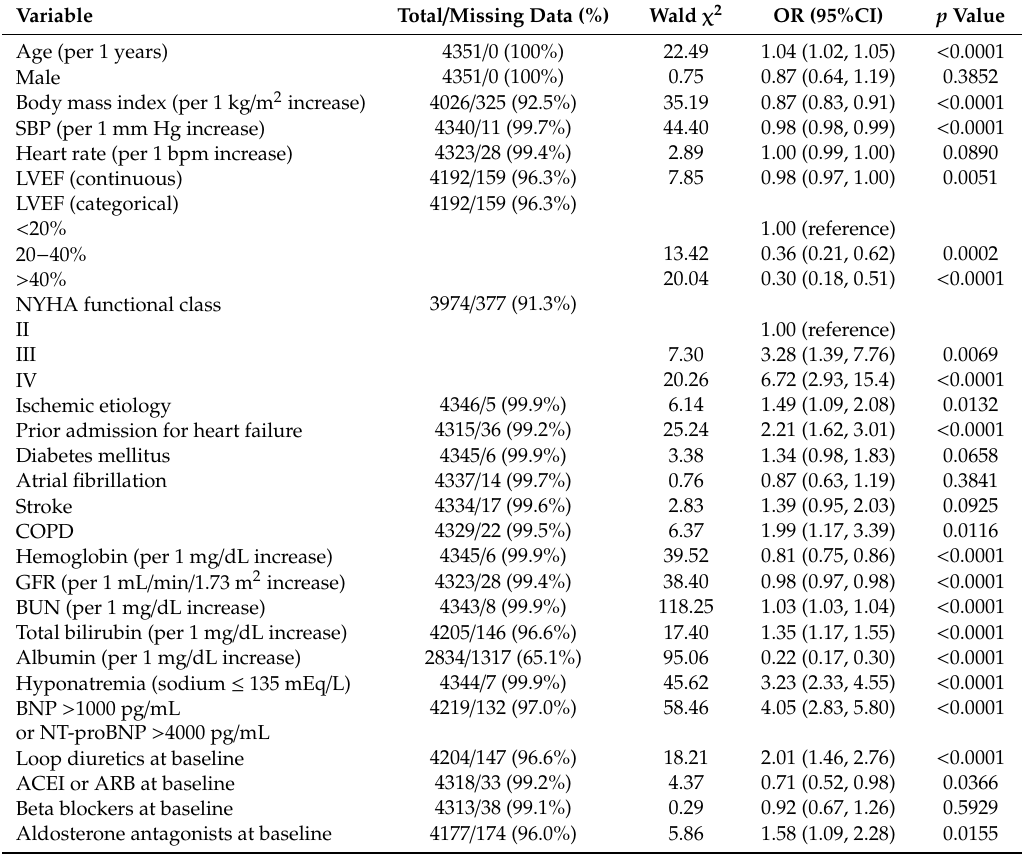
Table 2. Clinical variables contributing to in-hospital mortality.